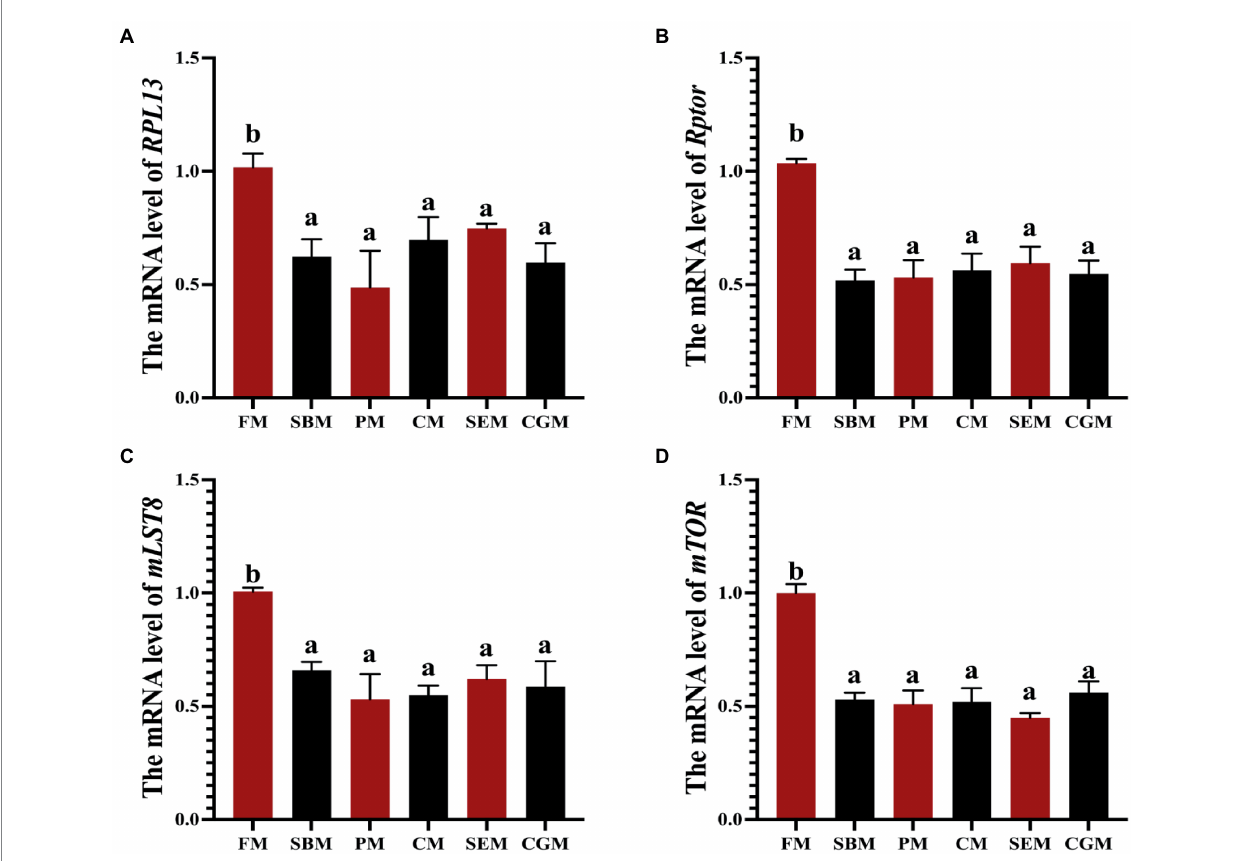
FIGURE 2 Data of mRNA levels of mTORC1 pathway genes ( RPL13, Rptor, mLST8, mTOR ) of muscle in yellow catfish (A–D) . The ratios of specific mRNA levels normalized to β -actin and GAPDH (used as a reference gene). Data from the FM group was set to 100% and used to normalize the remaining values. Within the figure, values without a common superscript letter (a–c) are different (c indicates a higher value). The dissimilar letters indicate significant differences ( p < 0.05), and values are means ± SEM of 3